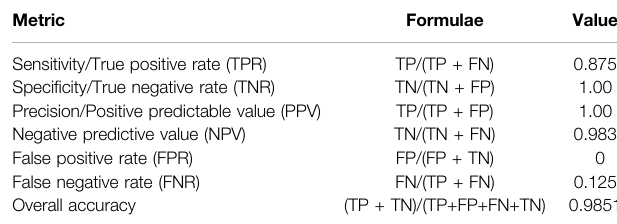
TABLE 2 | Interpretation of confusion